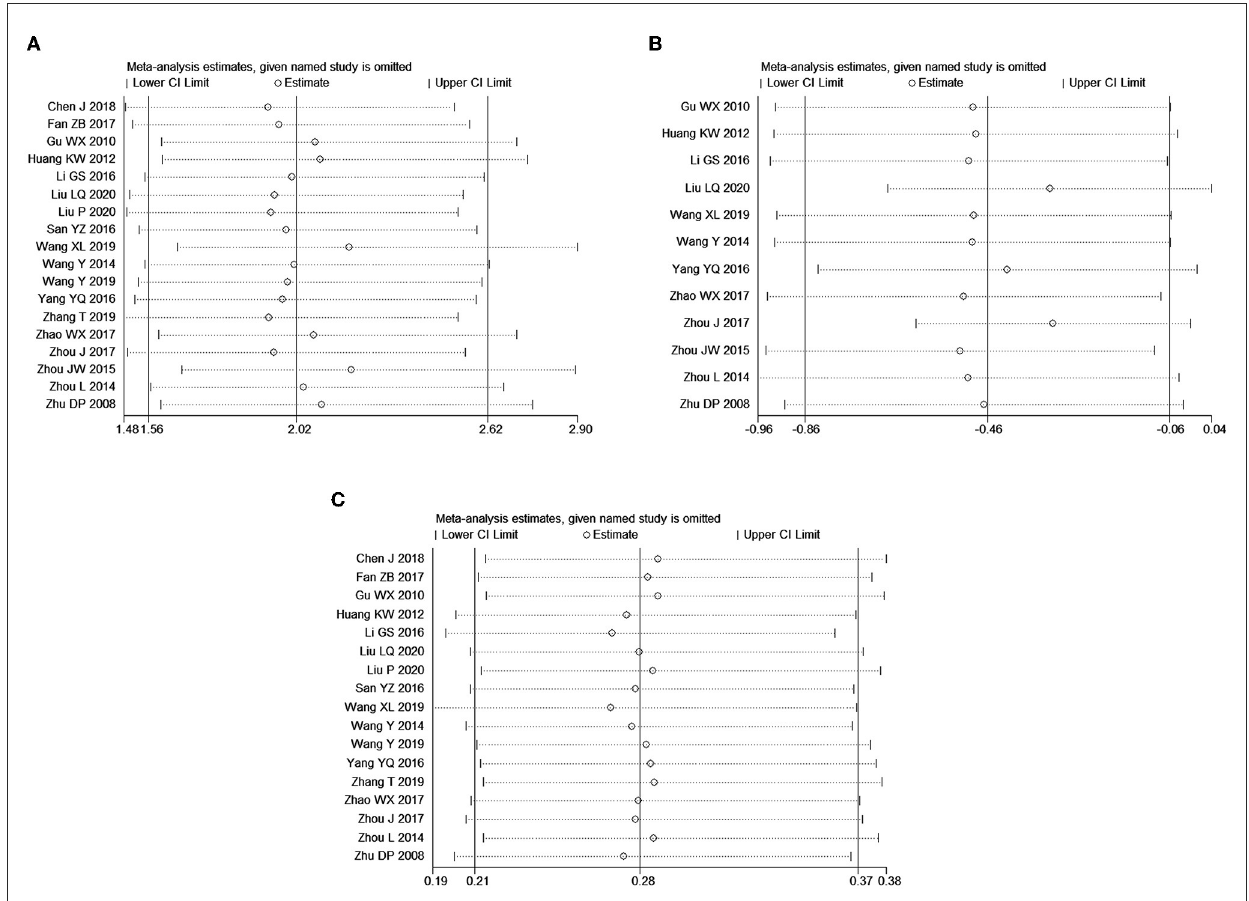
FIGURE7 Sensitivity analysis of meta-analysis for outcomes. (A) Effective rate; (B) VAS score; (C) adverse event